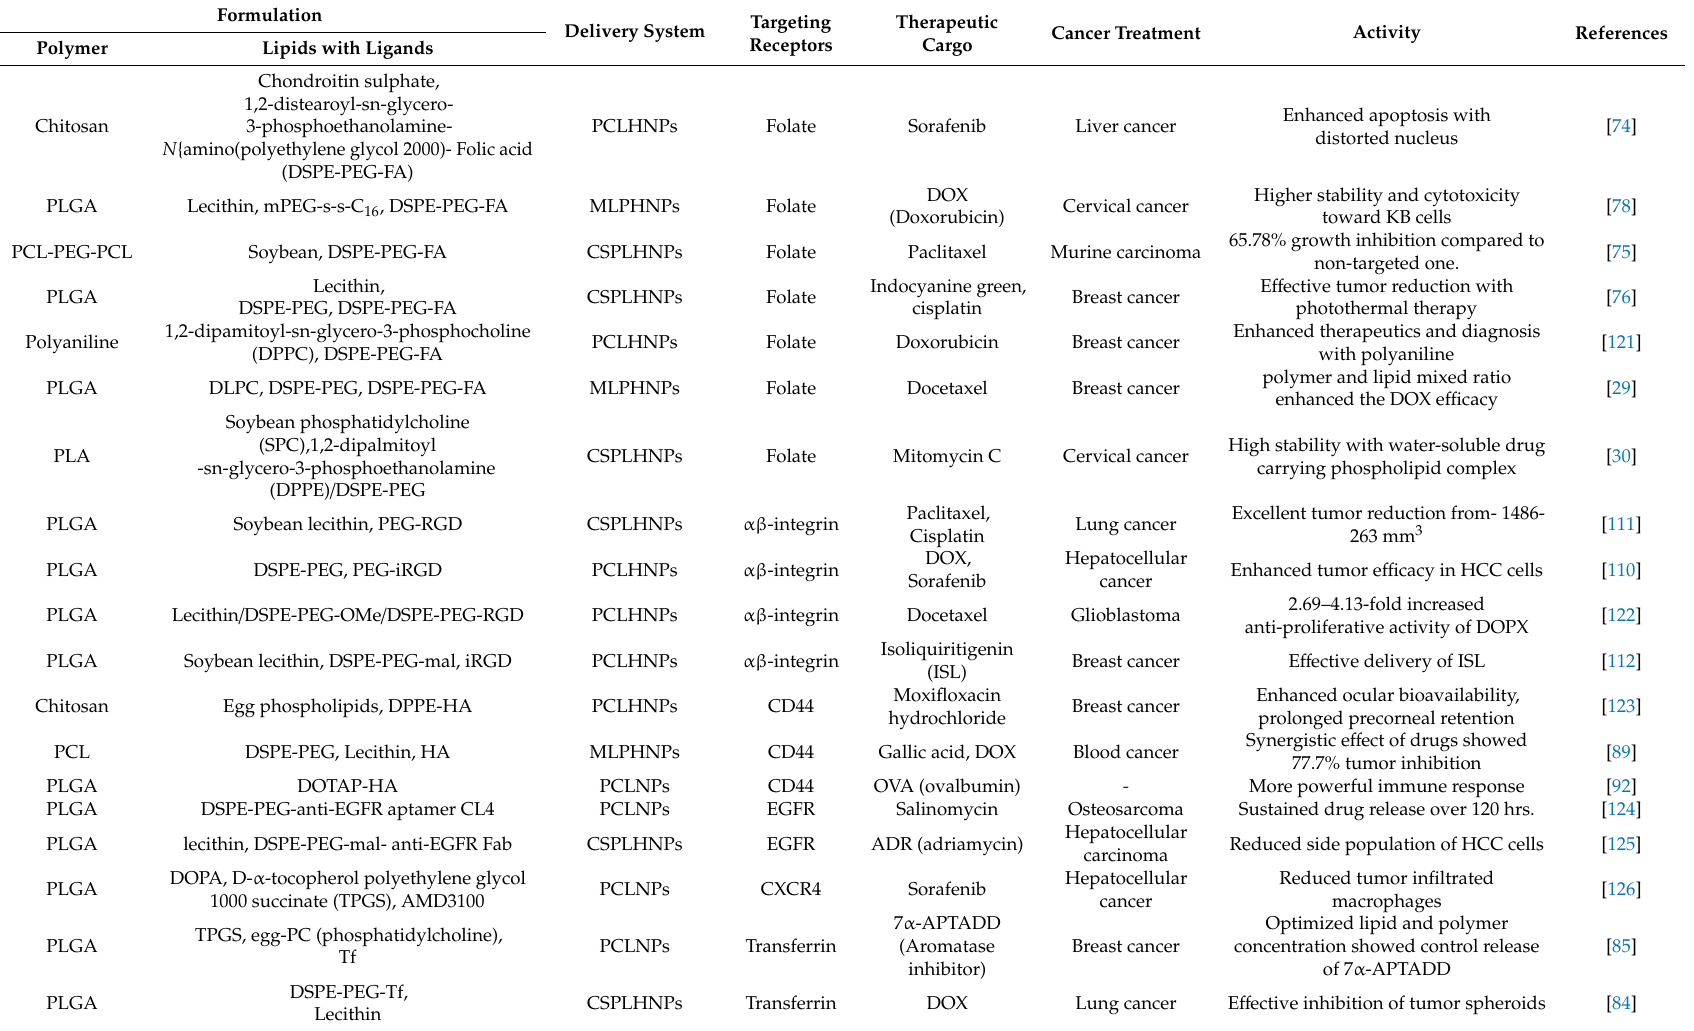
Table 2. Examples of active targeted PLHNPs designed for various anticancer